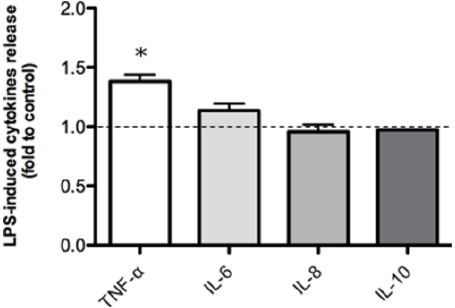
Figure 1. Cytokine release in Caco-2 cells after 24 h of LPS-stimulation (500 ng/mL). The dashed line represent the untreated control. * p < 0.05 vs. control.